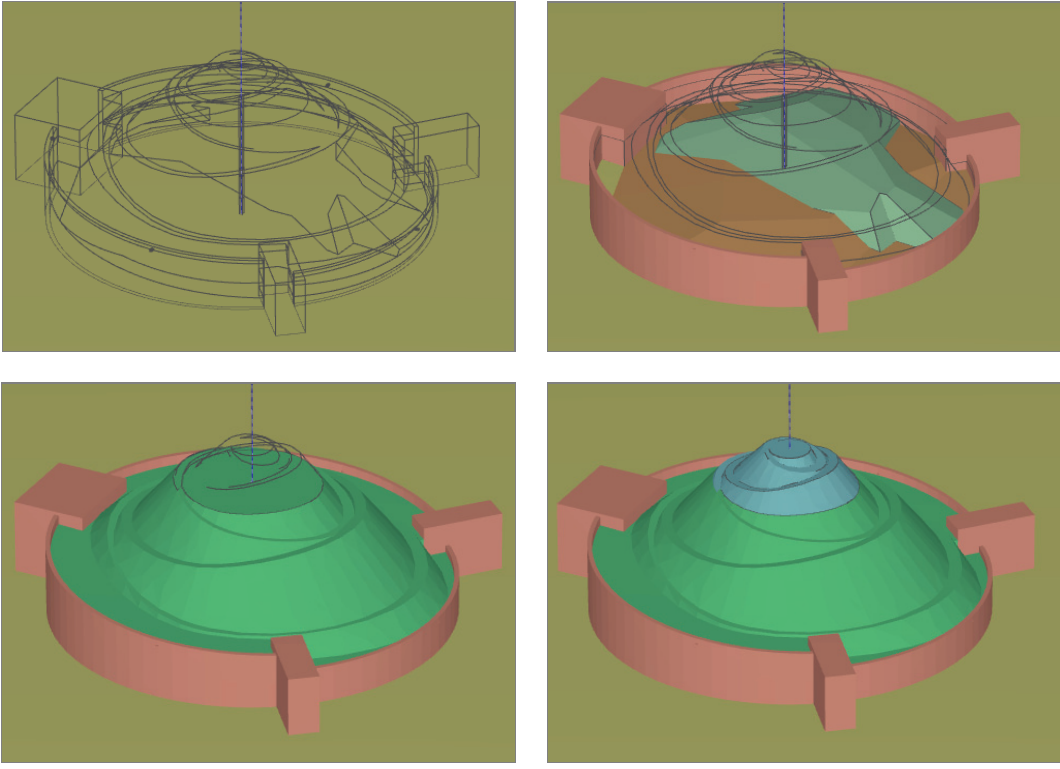
Fig. 8. Construction steps of the Mound to obtain the stress